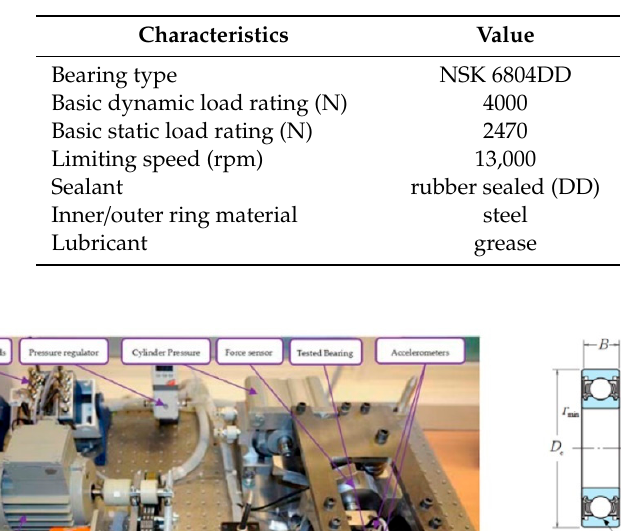
Table 1. Technical data of the ball bearings.